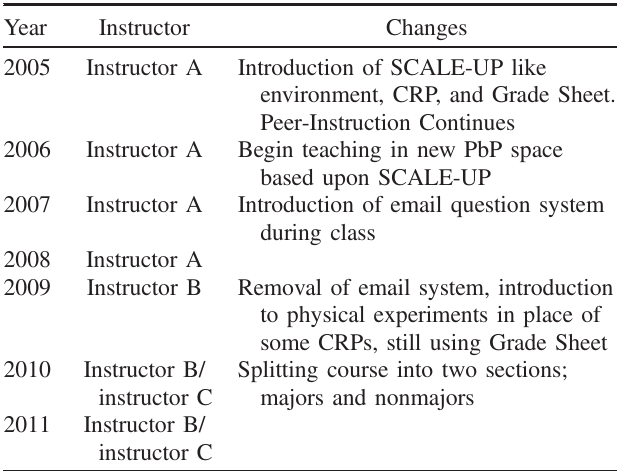
TABLE I. Summary of changes made to the Physics I course during the seven years of study. Only changes to the instruction are noted. If no changes are stated, the previous year was followed